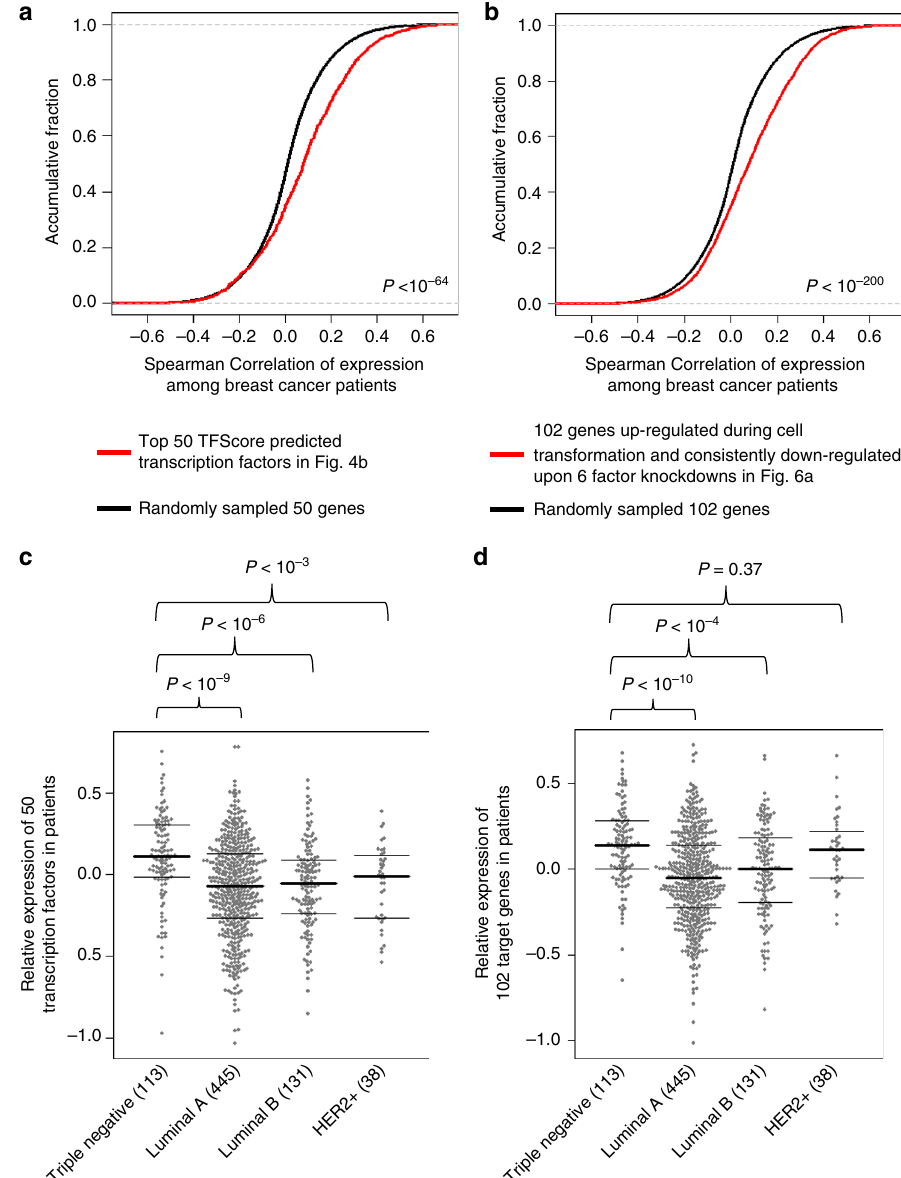
Fig. 7 Expression of TFs and targets in 1182 breast cancer patient samples. a The Spearman ’ s correlation of expression levels of top 50 TFScore predicted transcription factors in Fig. 4b. We randomly picked 50 expressed transcription factors and calculated their correlation values as the background distribution. The Wilcoxon Rank Sum test P -value is shown. b The Spearman ’ s Correlation of expression levels of 102 genes up-regulated during cell transformation and consistently down-regulated upon 6 factor knockdowns in Fig. 5a. We randomly picked 102 expressed genes and calculated their correlation values as the background distribution. The Wilcoxon Rank Sum test P -value is shown. c Relative expression of top 50 TFScore predicted transcription factor in indicated breast cancer subtypes. The numbers of patient samples were shown in parentheses, and the Wilcoxon Rank Sum test P - values comparing different groups are shown. d Relative expression of 102 target genes in indicated breast cancer subtypes. The numbers of patient samples were shown in parentheses, and the Wilcoxon Rank Sum test P -values comparing different groups are